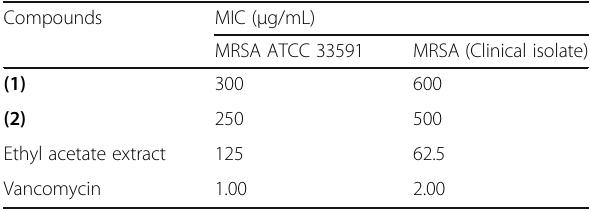
Table 3 Minimum inhibitory concentration (MIC) of gallic acid and methyl gallate against MRSA Compounds MIC ( μ g/mL) MRSA ATCC 33591 MRSA (Clinical